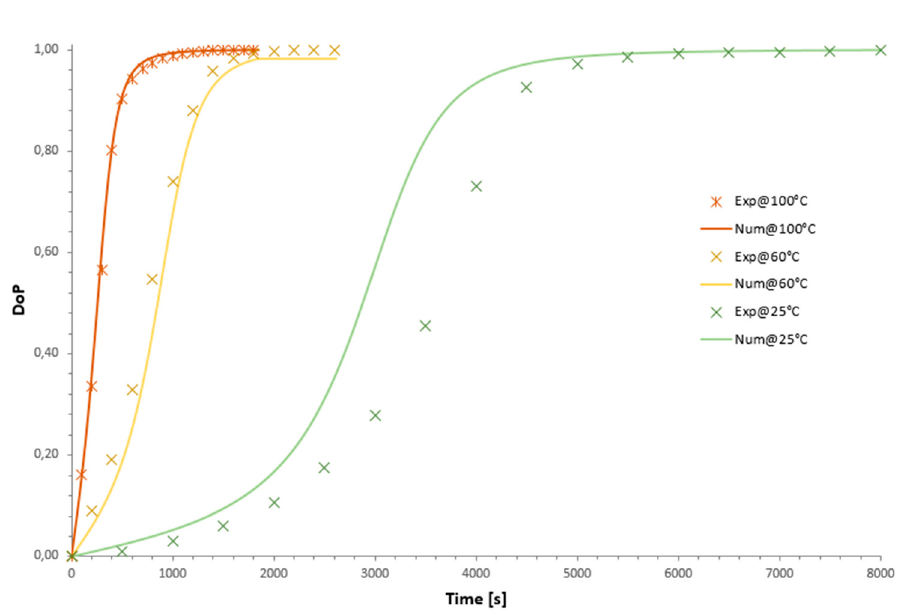
Figure 3. The polymerisation rate as a function of DoP for the experimental and predicted (best fit) DoP evolutions.